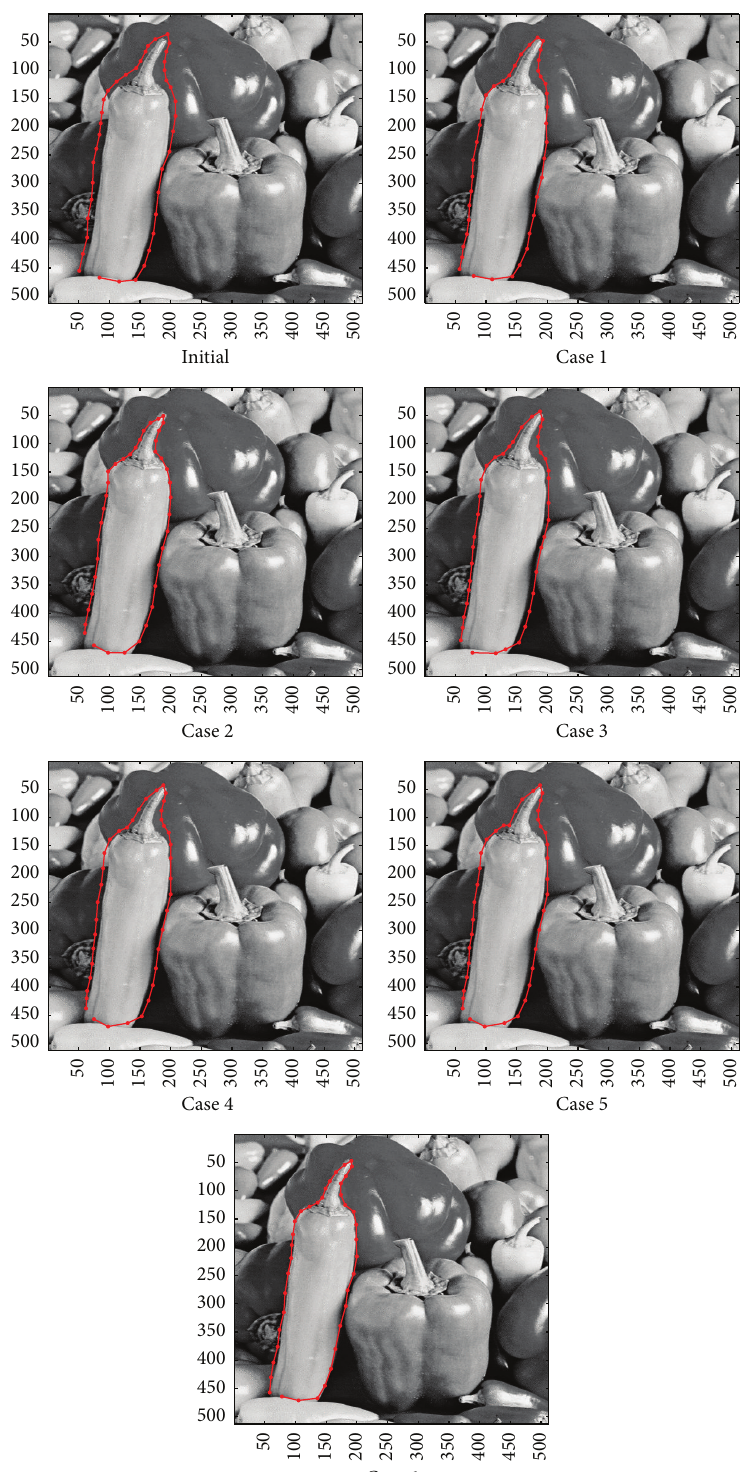
Figure 14: Active contour model implementation by “multipopulation PSO” method for different cases of inertia. Results for “Peppers” image with control points = 40, 𝛼 = 0.25 , 𝛽 = 0.22 , and Γ = 0.50